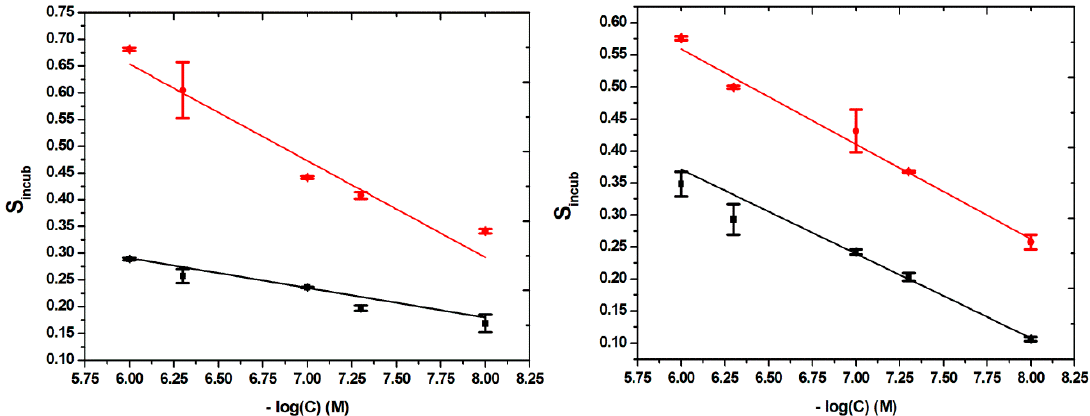
Figure 6. Linear relationship between MIP-based BDDE ( left ) and GCE ( right ) response (MIP (red) and NIP (black) and CFX concentration from 10 to 1000 nM.)